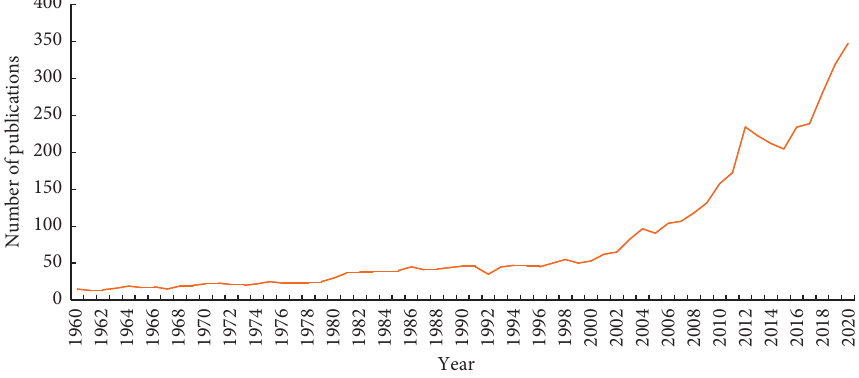
Figure 1: Annual trend of the number of